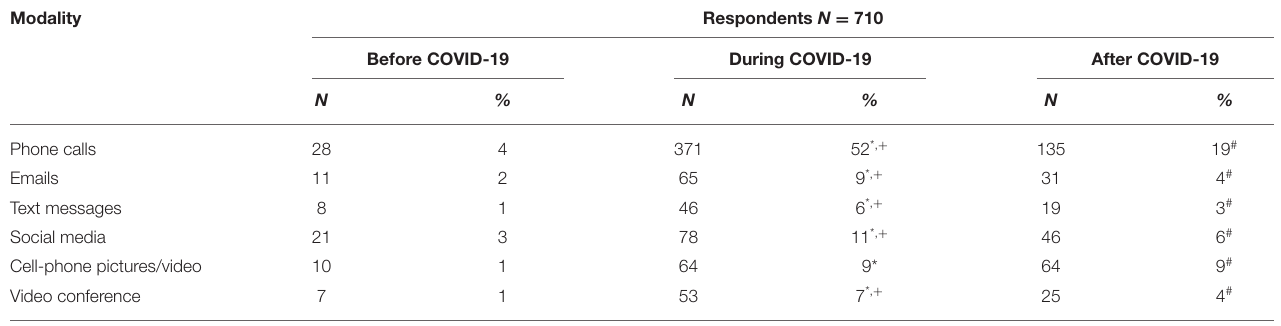
TABLE 2 | Use of telemedicine modalities for at least 50% of daily encounters. Modality